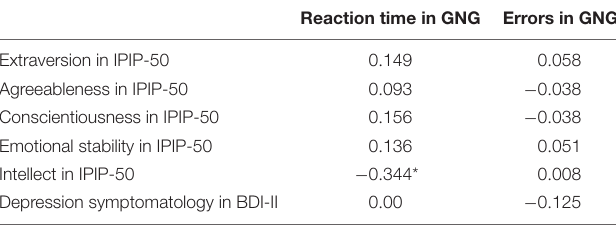
TABLE 3 | Pearson correlation coefficients for the relation of personality traits and depression symptomatology with cognitive response inhibition.